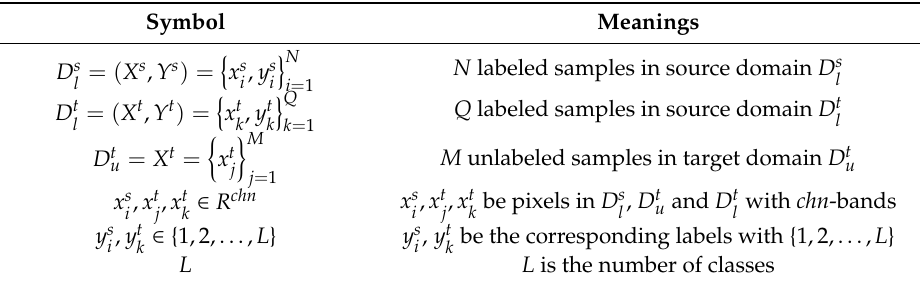
Table 1. Symbols and meanings.